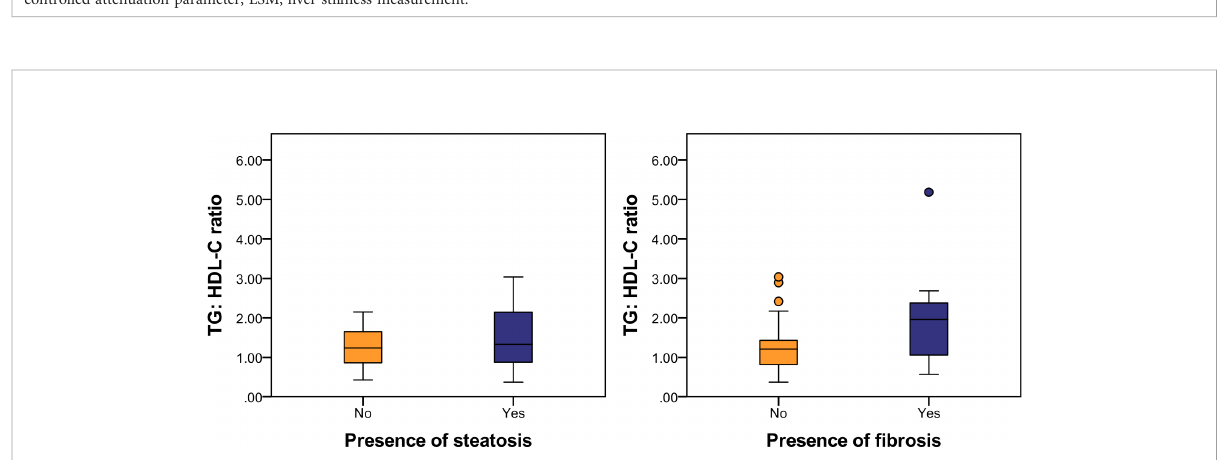
FIGURE 1 Relationship between TG: HDL-C ratio, liver steatosis and fi brosis. Mann-Whitney U tests were performed and results showed that patients with liver fi brosis have higher TG: HDL-C ratio (p = 0.013) whereas no difference was found among patients with liver steatosis. Signi fi cance was assumed when p